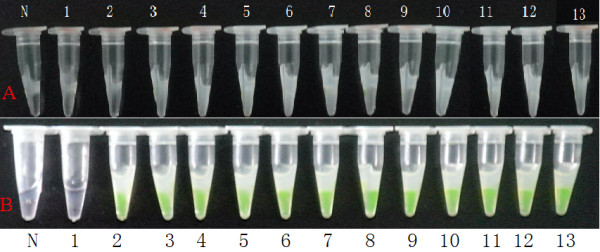
Detection of LAMP products by observing white turbidity and color of the reaction mixture. (A) shows white turbidity of the reaction mixture by magnesium pyrophosphate; (B) shows color (green) of the reaction mixture after addition of SYBR Green I. N, negative control; 1--12, reaction carried out using 10-fold serial dilutions of plasmid (pVP3) DNA (2.8 × 1011 copies/μl). 1: 2.8 × 100, 2: 2.8 × 101, 3: 2.8 × 102, 4: 2.8 × 103, 5: 2.8 × 104, 6: 2.8 × 105, 7; 2.8 × 106, 8: 2.8 × 107, 9: 2.8 × 108, 10: 2.8 × 109, 11: 2.8 × 1010, 12: 2.8 × 1011 copies/μl, respectively; 13:+, positive control.